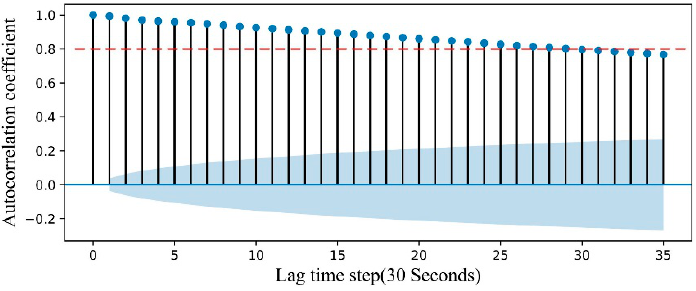
Figure 7. Auto-correlation within different sliding window sizes.